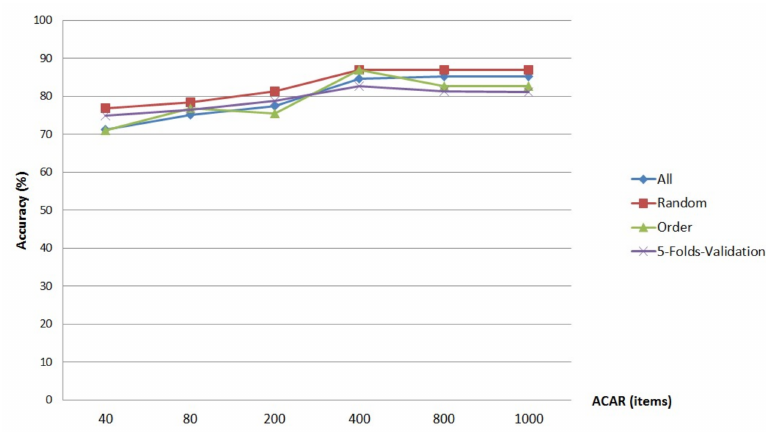
Figure 5. Classification accuracy based on CBA algorithm.